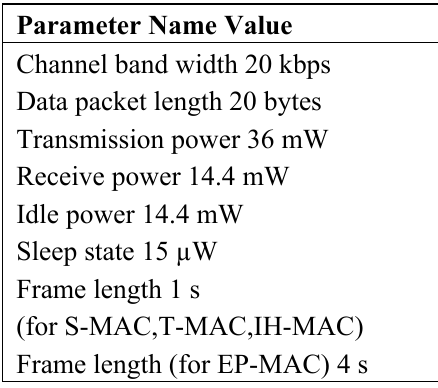
Table 1. Parameters for the MAC